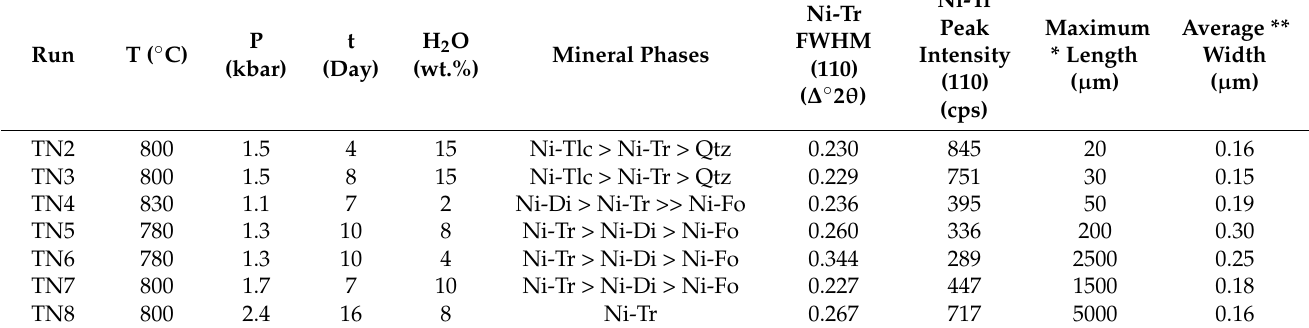
Table 1. Experimental conditions and product list of synthesis for each run, in the order of decreasing abundance, as detected by PXRD, SEM/EDS, EDS/EPMA. TEM/EDS and µ -R used only for run TN8. Ni-Tr = Ni-doped tremolite; Ni-Tlc = Ni-doped talc; Ni-Fo = Ni-doped forsterite; Ni-Di = Ni-doped diposide. Full width at half-maximum (FWHM). The statistical error for FWHM was estimated at ~10%, whereas for peak intensity it was